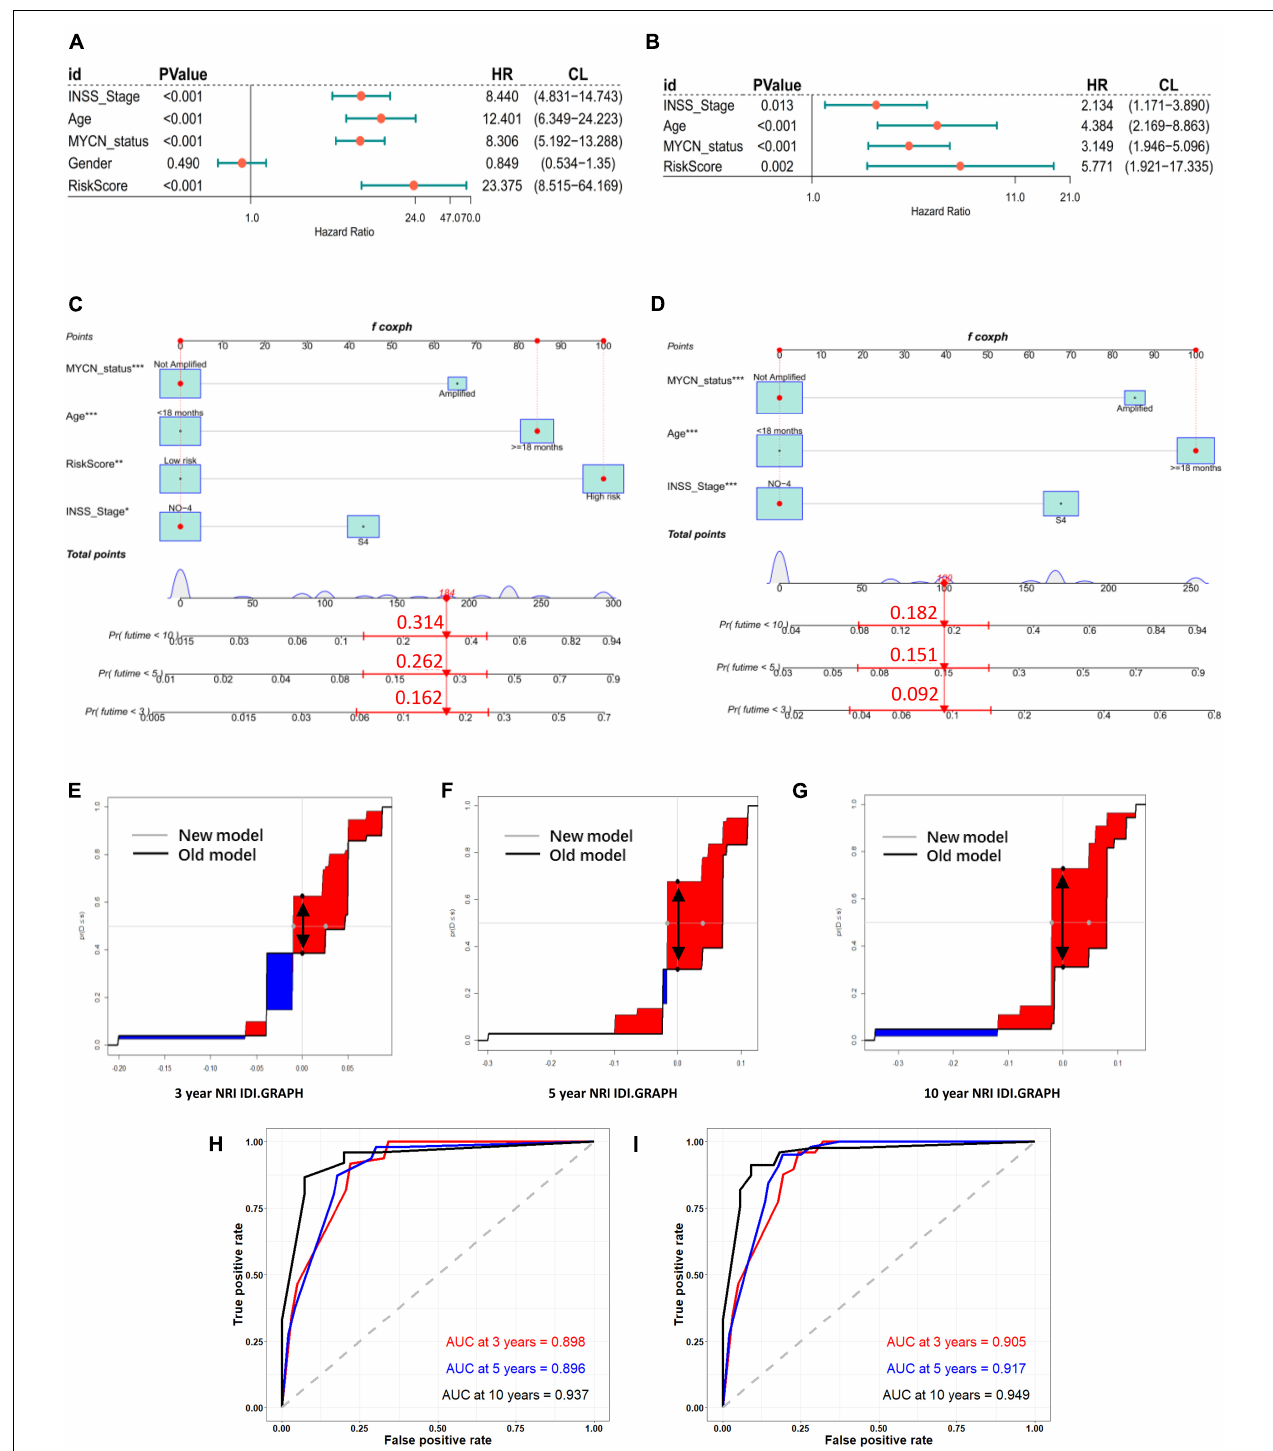
FIGURE 5 | Models of risk score and clinical variables were established, compared, and verified. Forest plot of univariate (A) and multivariate (B) Cox regression results of RiskScore (define ATGs risk signature as a variable) and clinical variables. Establishment of nomograms including new models (RiskScore plus) (C) and old models (clinical variables only) (D) . NRI and IDI for 3- (E) , 5- (F), and 10- (G) year graph in new models (RiskScore plus) and old (clinical variables only). NRI is showed as distance between two black spots (double arrow); IDI is showed as area difference between red part and blue part. ROC curves of old (H) and new (I) models for predicting 3-, 5-, and 10-year